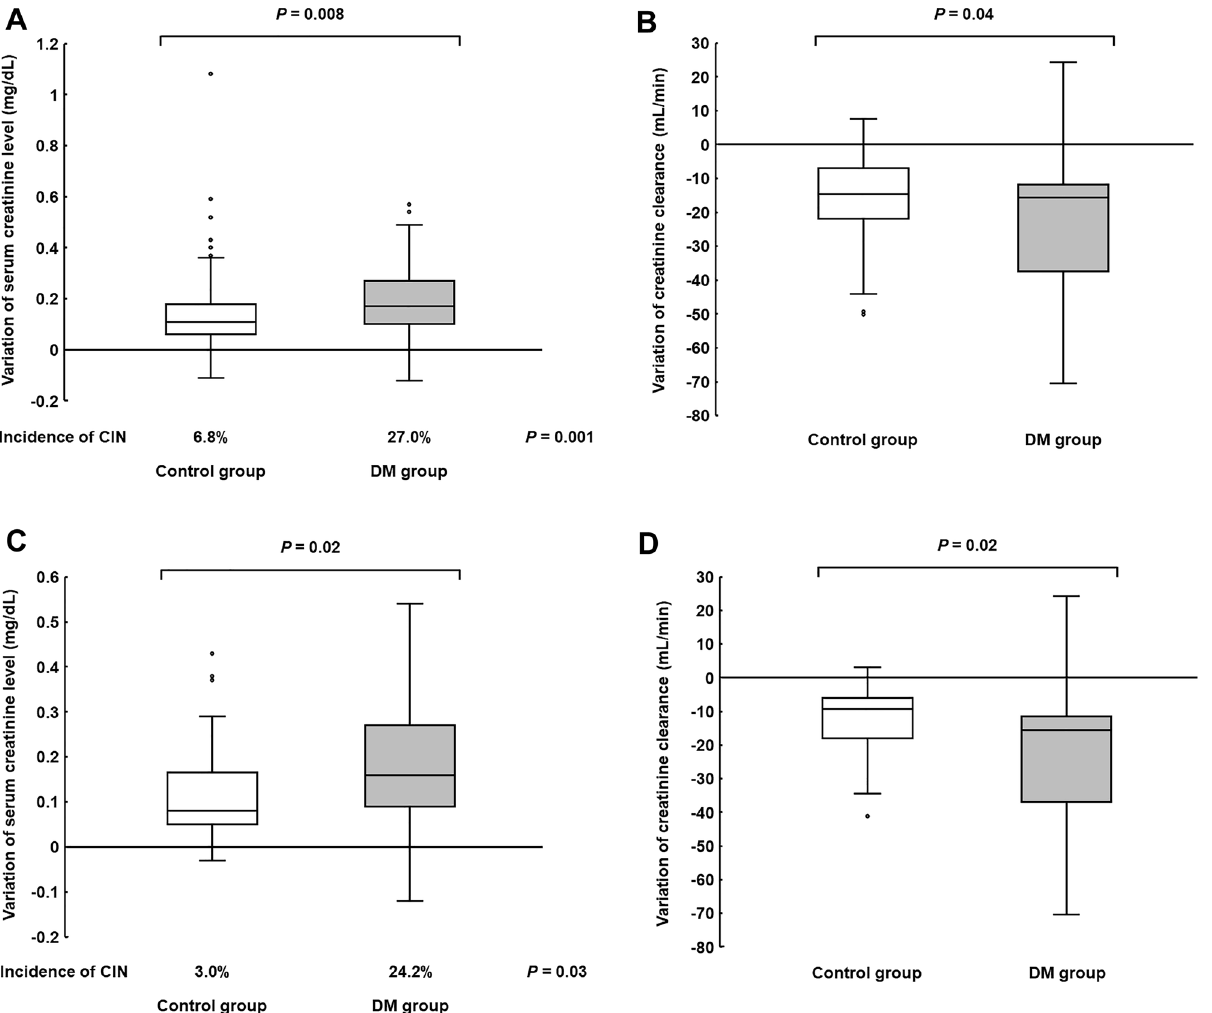
Figure 2. Comparison of ( A ) CIN incidence and SCr variation and ( B ) CCr variation in all-patient population, and ( C ) CIN incidence and SCr variation and ( D ) CCr variation in propensity-matched population. CIN, cisplatin-induced